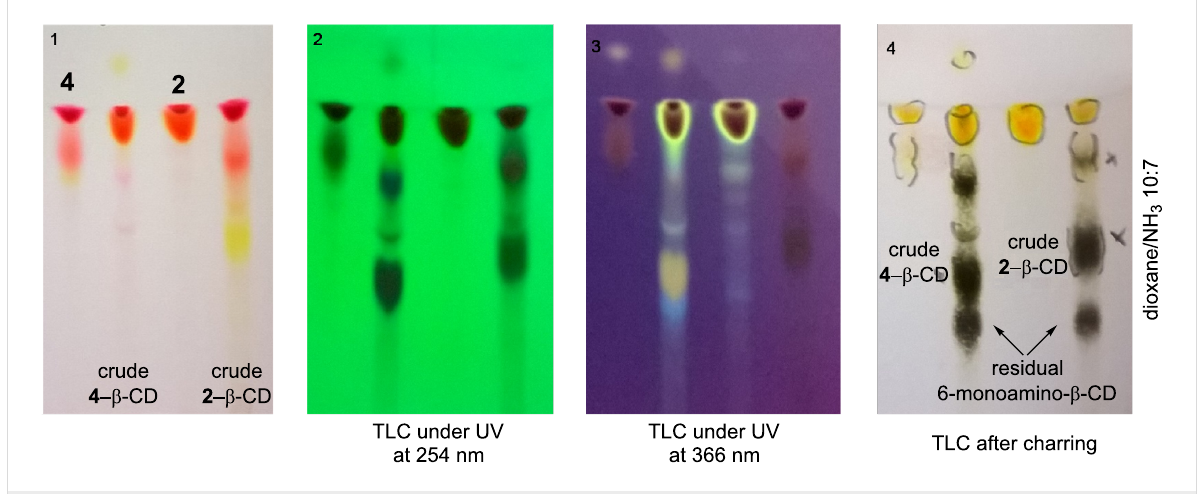
Figure 3: TLC analysis of the composition of the crude coupling reaction mixtures.